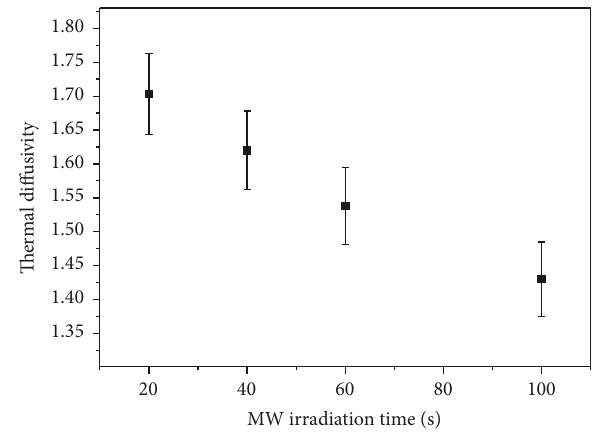
Figure 9: Thermal diffusivity Ag nanofluids with varying MI